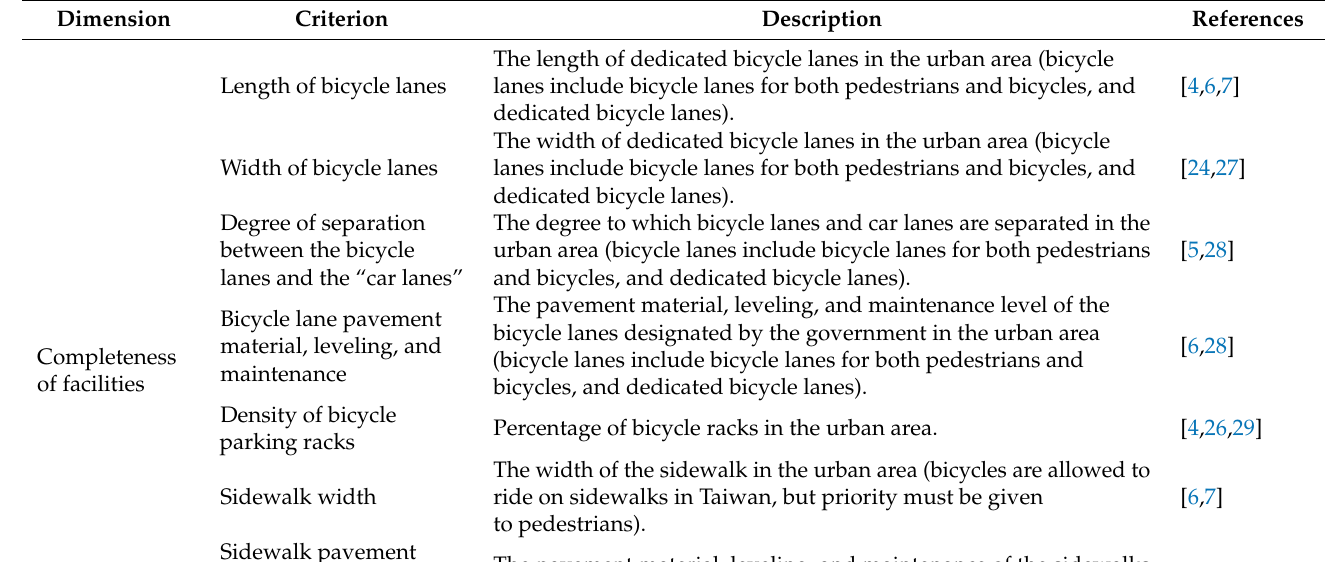
Table 1. Proposed dimensions and criteria for bikeability